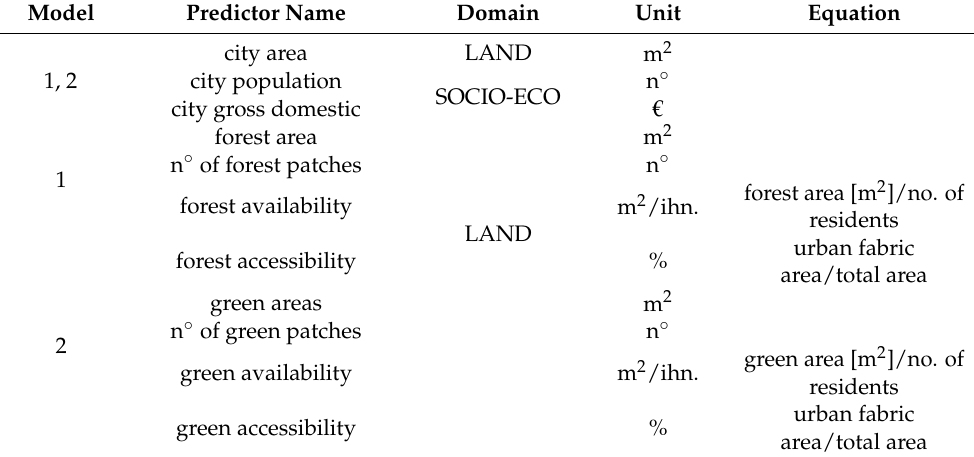
Table 1. Common and specific predictors of landscape metrics (LAND) and socio-economic variables (SOCIO-ECO) for the two GLMMs used respectively for forests (model 1) and green urban areas (model